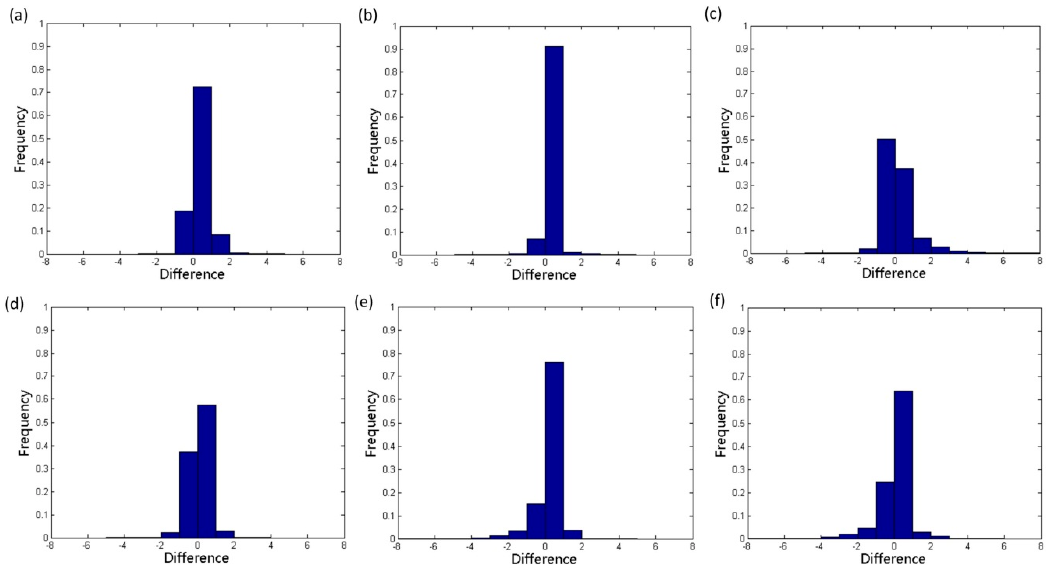
Figure 8. Frequency histograms of LAI differences: ( a ) GLASS vs. MODIS; ( b ) GLOBALBNU vs. MODIS; ( c ) GLOBMAP vs. MODIS; ( d ) GLASS vs. GLOBALBNU; ( e ) GLASS vs. GLOBMAP; ( f ) GLOBALBNU vs. GLOBMAP.